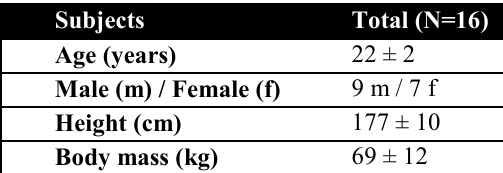
Table 1: Subjects' characteristics (mean ± S.D.).